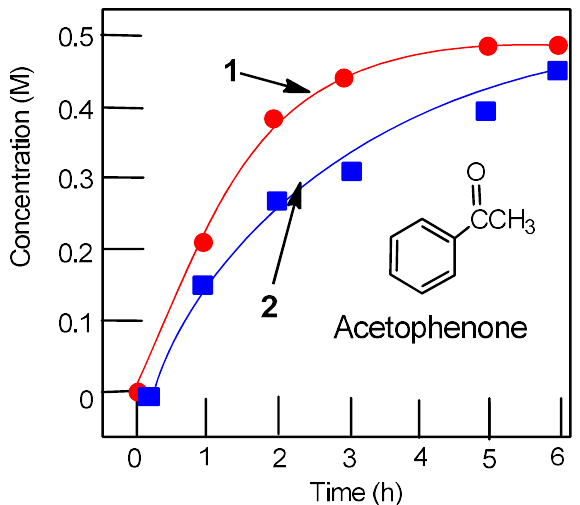
Figure 9. Accumulation of acetophenone in oxidation with tert -butyl hydroperoxide catalyzed by complex 1 (Curve 1) and by complex 3 (Curve 2). Conditions: 1-phenylethanol (0.5 M), tert -butyl hydroperoxide (1.5 M, aqueous 70%), acetonitrile up to 5 mL, catalyst (5 × 10 −4 M), 50° C. Reaction quenched by the addition of PPh 3 .